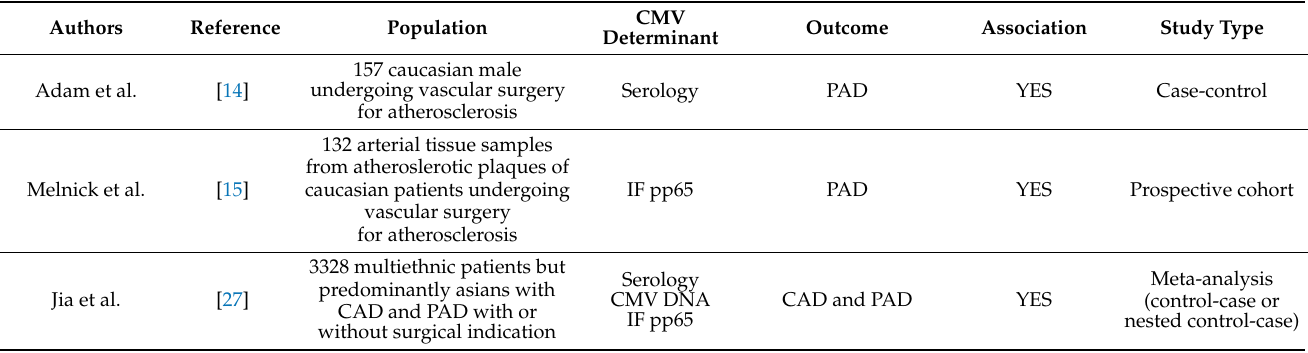
Table 1. Associations between CMV, atherosclerosis, and cardiovascular